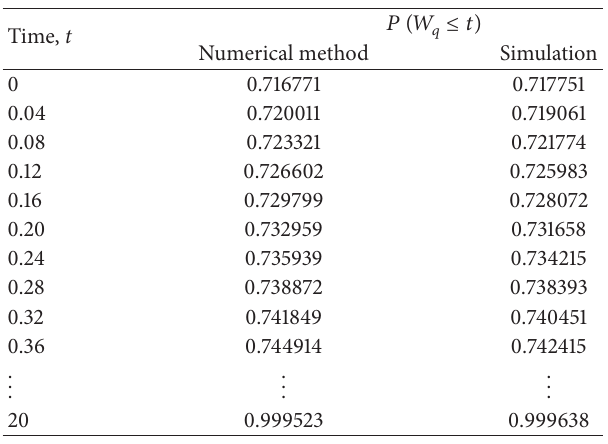
Table 3: Comparison of stationary waiting time distribution com- puted, respectively, by using the proposed numerical method and the simulation procedure ( Δ𝑡 =